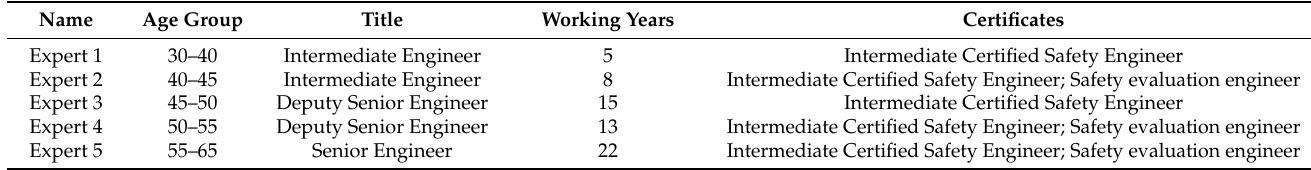
Table 2. Relevant information of expert group.